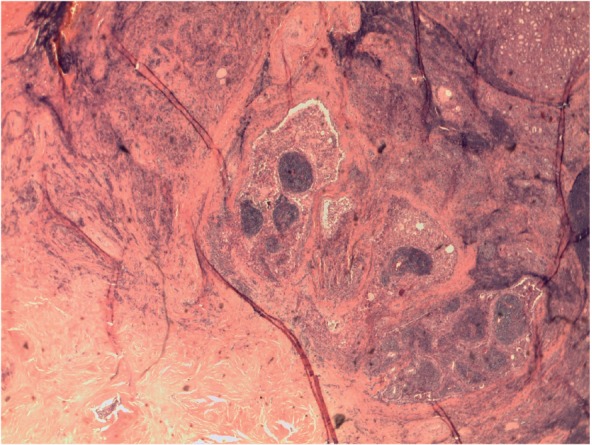
Papillary carcinoma Warthin-like merging with sclerosing ones.